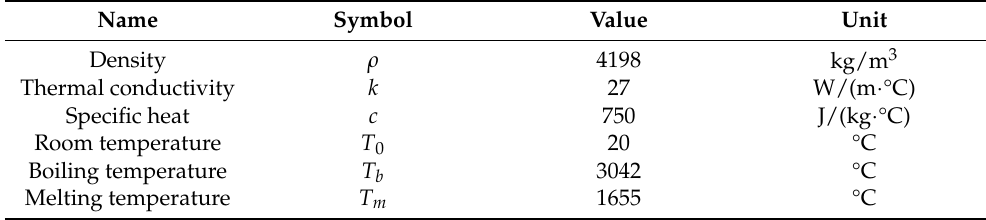
Table 2. Material properties of Ti6Al4V